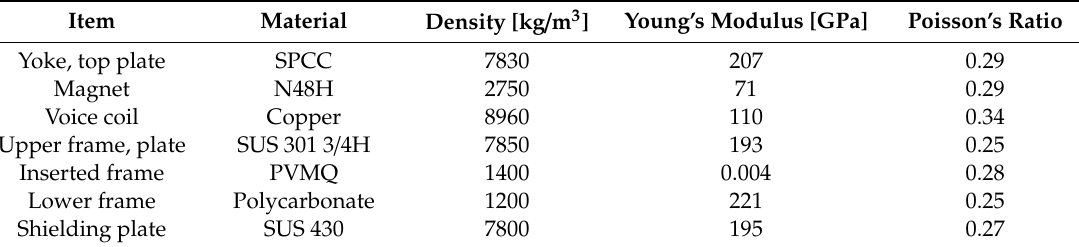
Table 1. Mechanical material